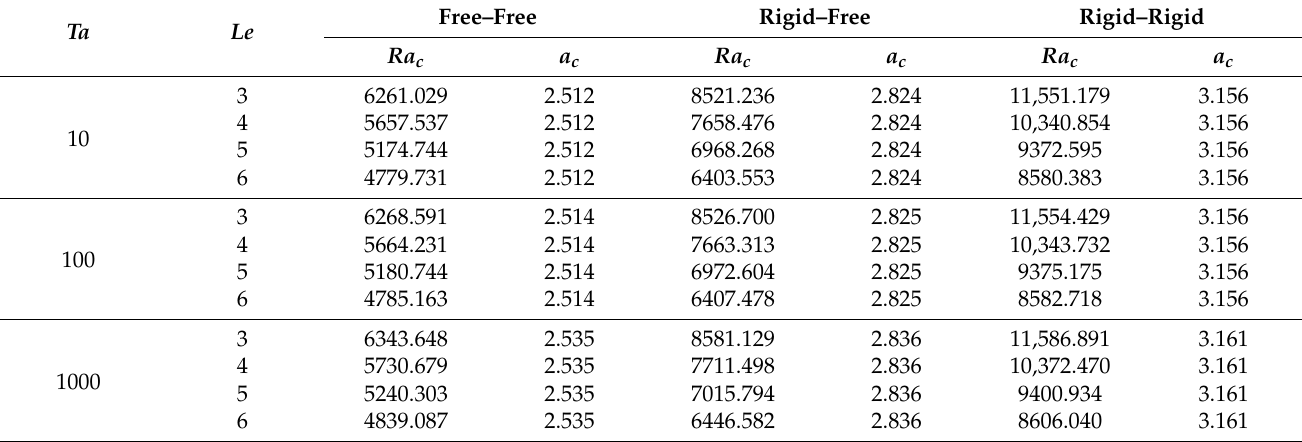
Table 6. Critical values of Ra and a for Da = 0.01, Du = 0.02, Rs = 200, Sr = 0.2, Λ = 8, M = 0.9, φ = 0.9.